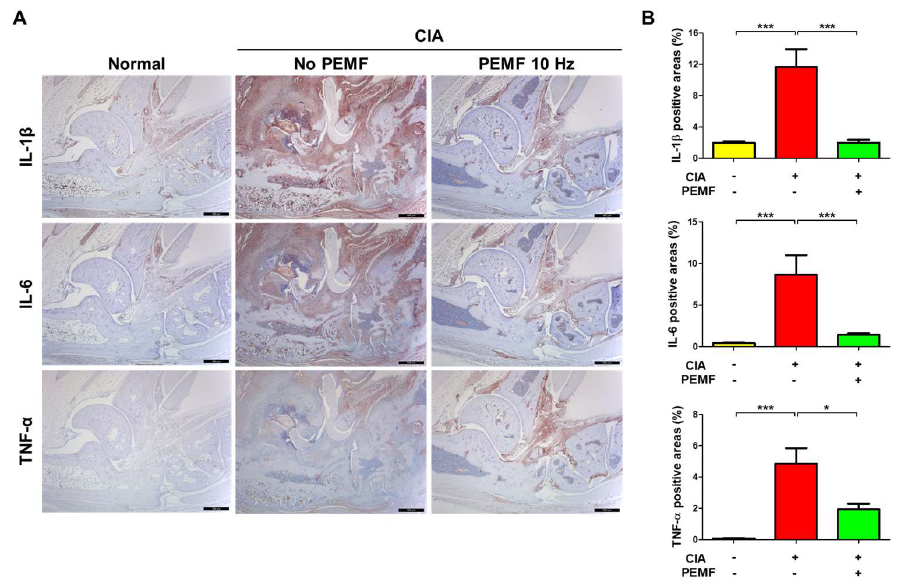
Figure 5. Effects of PEMF (10 Hz) on IL-1β, IL-6, and TNF-α expression in ankle joint tissues. ( A ) Immunohistochemical staining of IL-1β, IL-6, and TNF-α in ankle joint paraffin sections. The magnification is × 40. Bar, 500 µ m. ( B ) Histograms showing the percentage of positive tissue area for IL-1 β , IL-6, and TNF- α . Data are presented as the mean ± standard error of the mean (SEM). Normal, n = 7; CIA, n = 6; CIA+PEMF 10 Hz, n = 10. Significance was measured using a two-tailed Student’s t -test (* p < 0.05 and *** p < 0.001).